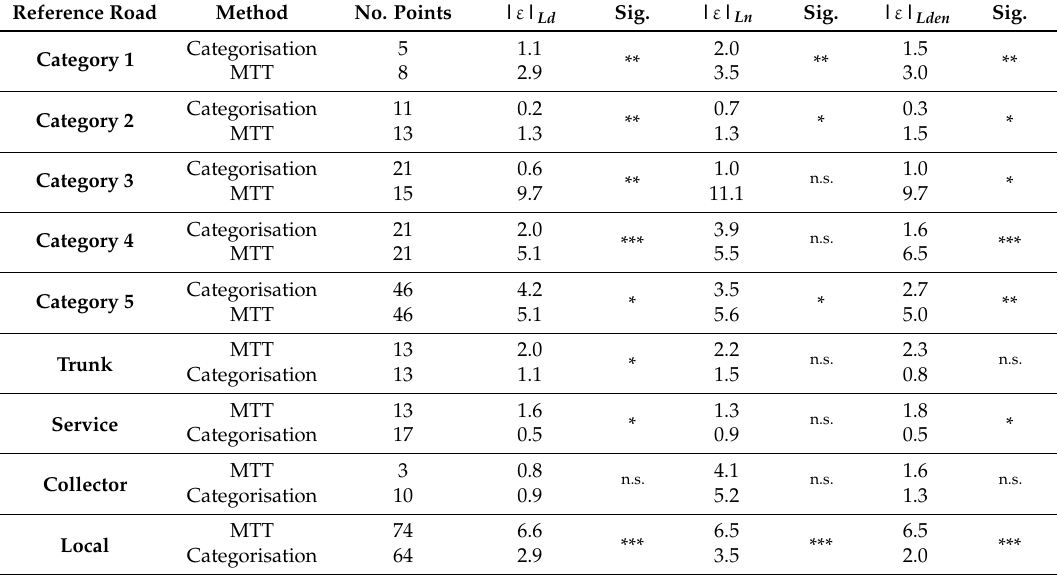
Table 6. Absolute values of prediction errors (| ε |) for L d , L n and L den for road types and road categories and comparison to prediction errors of both methods (Categorisation and Ministry of Transport and Telecommunication (MTT)) using Mann-Whitney U